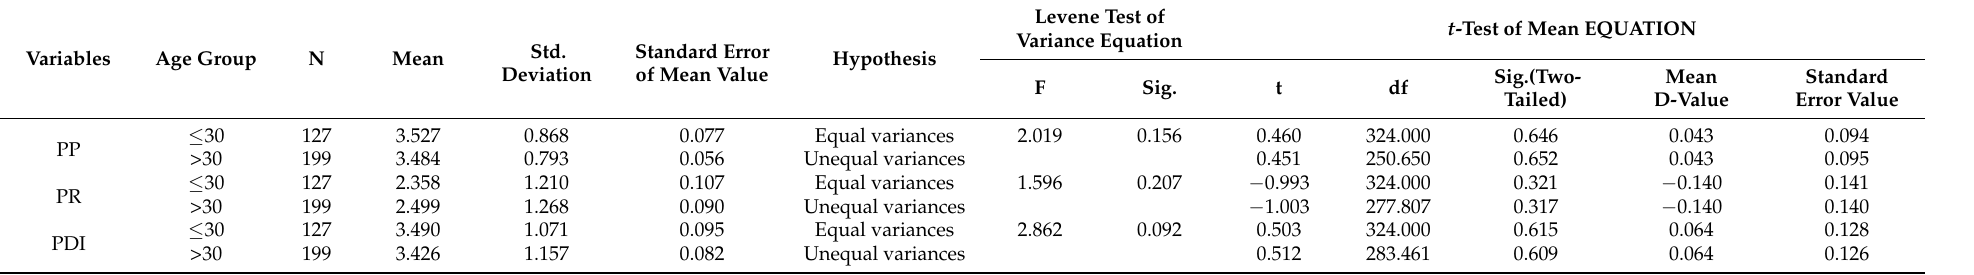
Table 5. Group statistics and independent sample test.